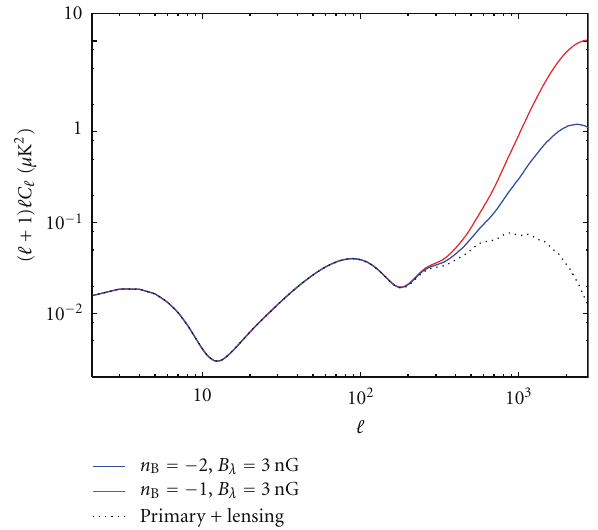
Figure 6: CMB polarization anisotropies from the PMF. Blue thin and red-bold curves show ( B λ , n B ) = (3 . 0nG, − 2 . 0) and ( B λ , n B ) = (3 . 0nG, − 1 . 0). The black-dotted curve shows a primary spectrum with weak lensing e ff ects (without the